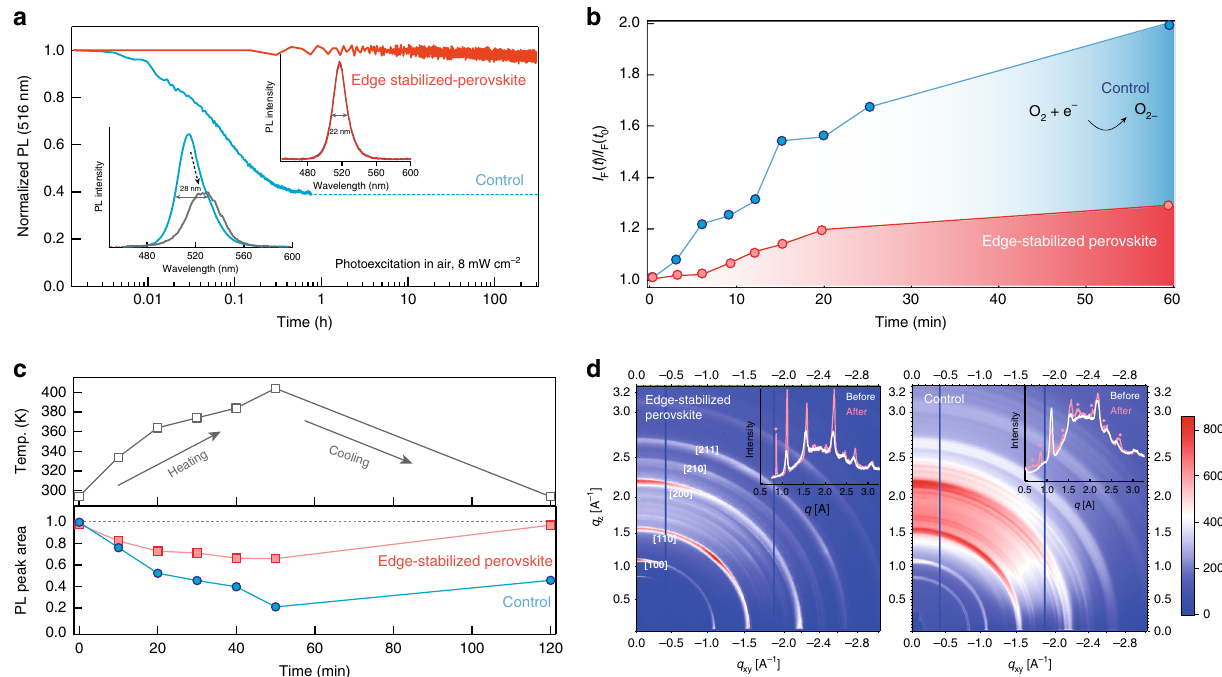
Fig. 3 Photothermal stability. a PL stability under continuous excitation under a 374-nm laser diode. The inset shows PL spectra of the untreated control and edge-stabilized sample before (in red and blue, respectively) and after (in gray) measurement. b Normalized fl uorescence intensity of the superoxide probe solution. c Thermal stability of the untreated control and edge-stabilized perovskite under a continuous heat stress. d In situ GIWAXS of the untreated control and edge-stabilized perovskite. The fi lms were gradually annealed up to 150 °C, let there for 30 min before cooling down and measured. The inset curves show the out-of-plane line pro fi les before and after heat